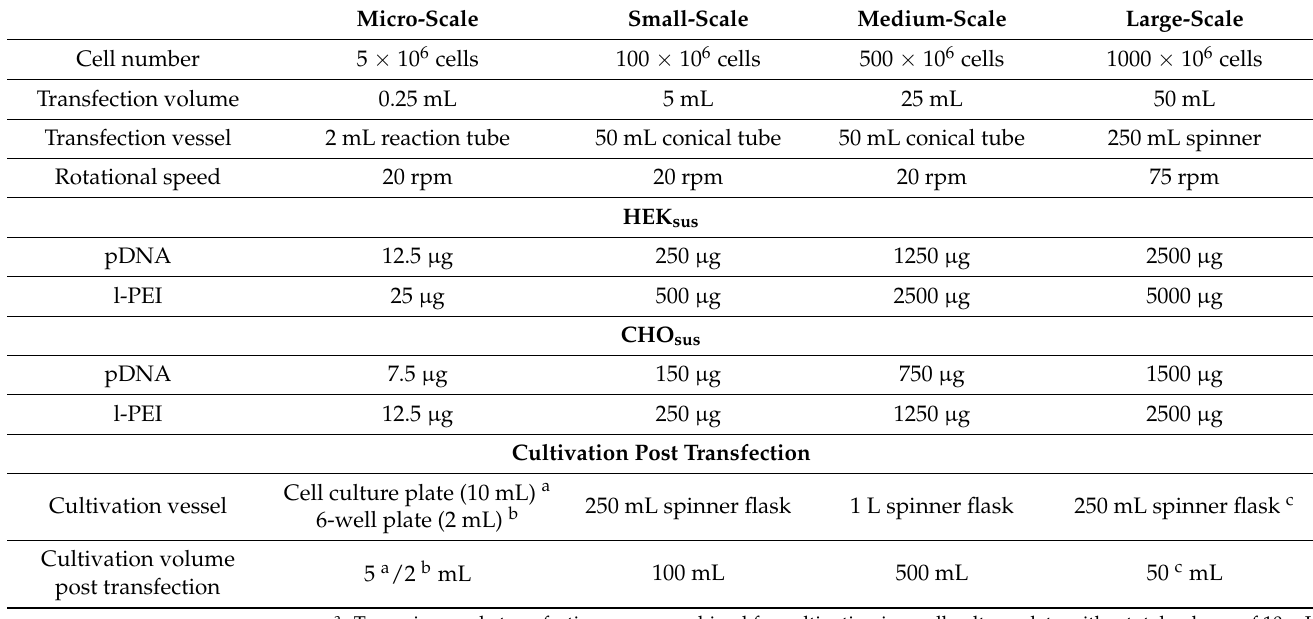
Table 1. Experimental setups used in the high cell density transfection.